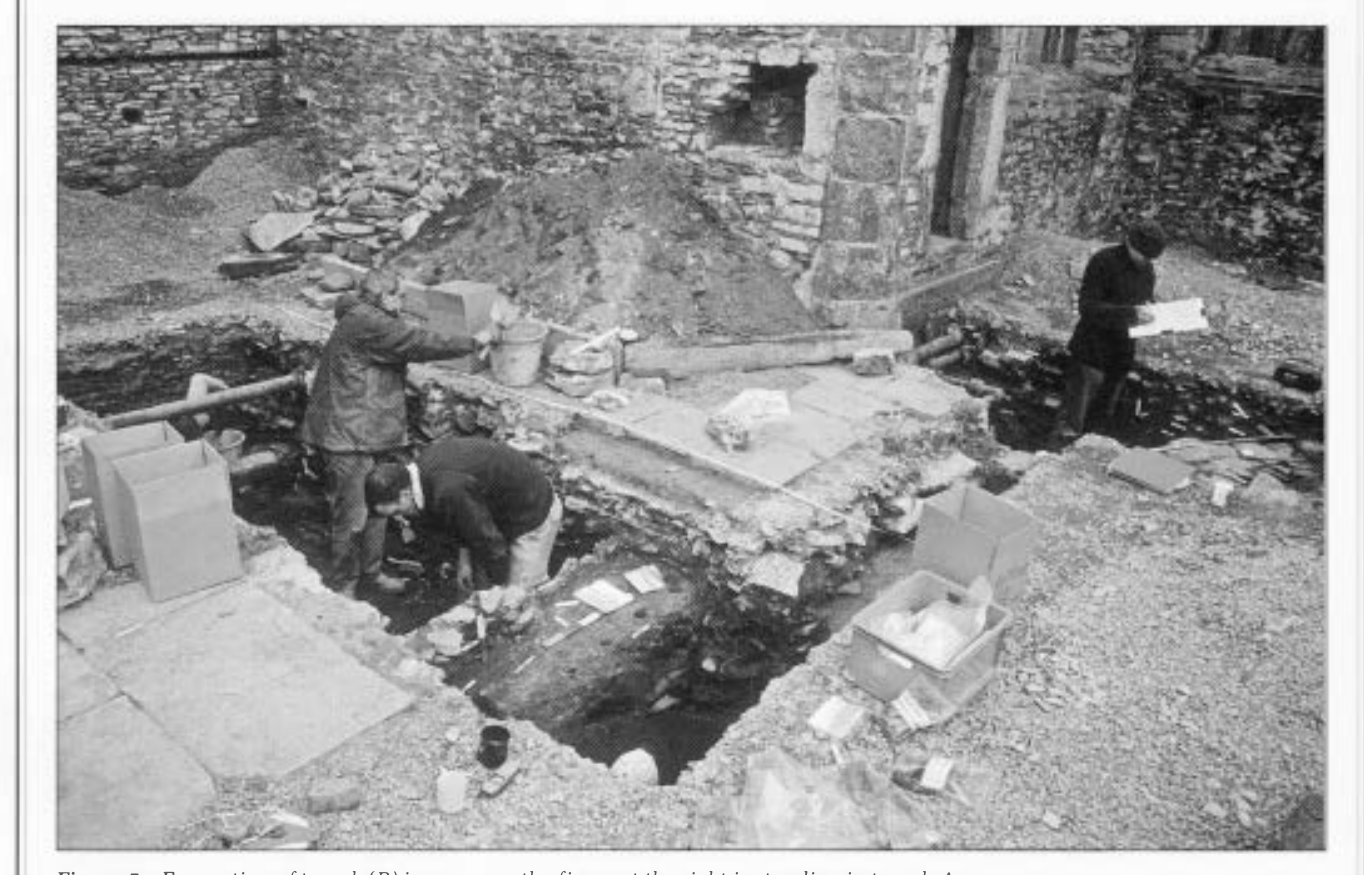
Figure 5 Excavation of trench (B) in progress; the figure at the right is standing in trench A.